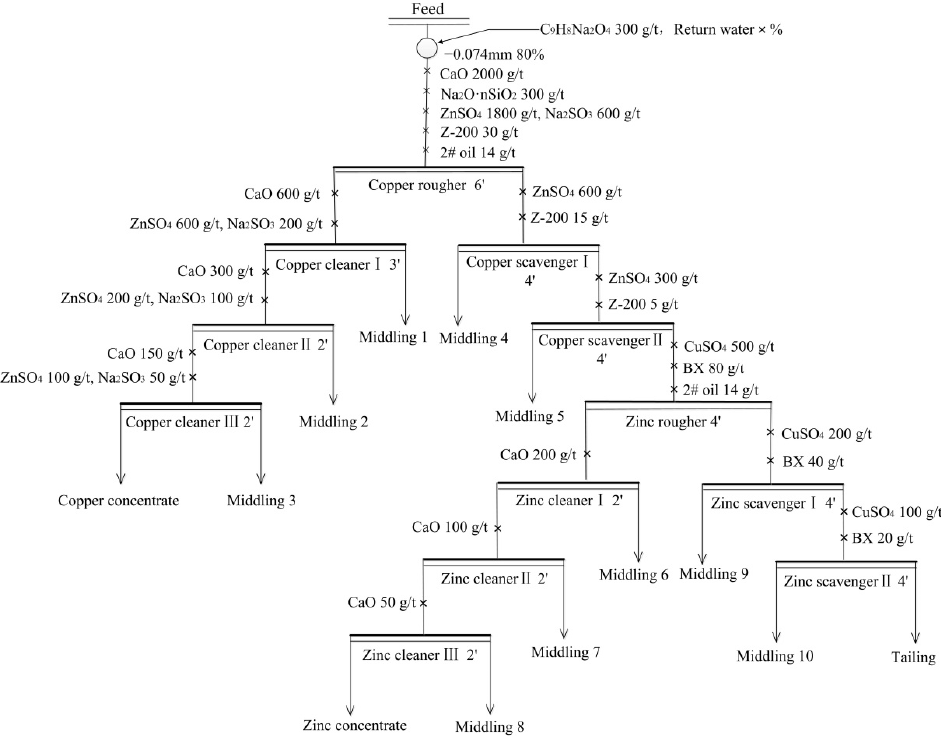
Figure 17. The experimental flowchart of reuse of return water.